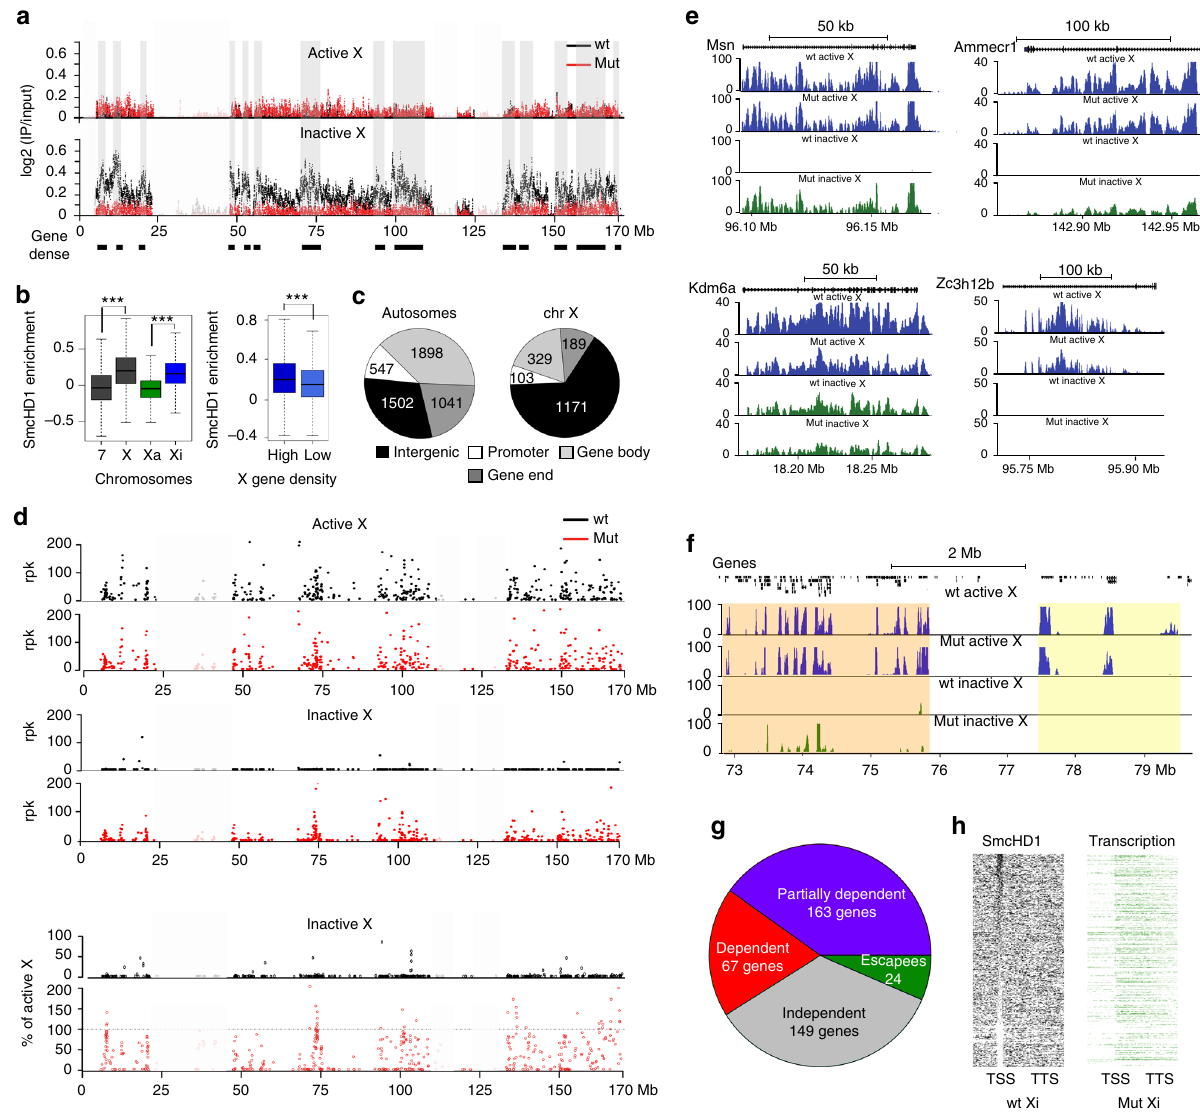
Fig. 1 Widespread derepression of Xi genes in SmcHD1 mutant MEFs. a Chromosome-wide pro fi les of SmcHD1 occupancy on Xa and Xi depicted as allele- speci fi c ChIP-seq enrichment (log2 ratios of IP to input per 500 bp) binned into 10 kb intervals. Pro fi les from wt and germline SmcHD1 mutant (mut) MEFs are presented. Shaded areas and black bars below the pro fi les depict gene-dense areas. Throughout the fi gure regions of low mappability are indicated with reduced colour intensity. b SmcHD1 enrichment within 10 kb bins on chr7, X (both alleles), Xa and Xi. Right panel shows differences in SmcHD1 enrichment over chrX regions with high and low gene density. Boxplots present quartiles, median and outliers of ChIP enrichment. Signi fi cance estimated with Mann – Whitney test ( p -value < 10 – 4 ). c Genic and intergenic distribution of SmcHD1 peaks (MACS2, FDR < 0.05) on autosomes and chrX. d Quanti fi cation of gene expression on Xa and Xi with allele-speci fi c chromatin RNA-seq in wt and mut MEFs. Normalized read count per 1 kb of gene body is shown. Lower panel depicts gene expression on wt and germline SmcHD1 mutant Xi presented as % of Xa expression. e Representative examples of individual X-linked genes (UCSC screen shots). f Example of a ~7 Mb region with a domain of strongly activated Xi genes, followed by a domain of Xi genes activated to a lesser degree (both with orange shading), and by a domain with genes expressed on Xa and silenced on Xi in mut cells (yellow shading). g Summary of gene expression analysis. X-linked genes expressed on Xa were divided based on their transcriptional status on Xi into SmcHD1-dependent (expression not signi fi cantly different from Xa), partially SmcHD1-dependent (de-repressed but expressed signi fi cantly lower level than Xa), SmcHD1-independent (silenced on Xi) and wt escapees. h Occupancy of SmcHD1 on genes (expressed on wt Xa, > 5 kb). Heatmap presents log2(IP/input) values from wt cells reduced by values for the same regions in mut cells. Right panel: de-repressed genes (transcription) on mut Xi. Genes on both heatmaps are ordered in the same way according to decrease of SmcHD1 at the